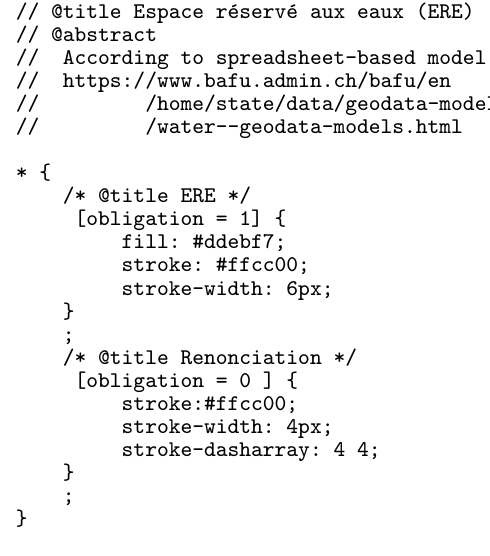
Figure 3. Styling and symbology instructions according to a spreadsheet-based model ( Area reserved for water MGM) Such styling and symbology instructions described in spread- sheet may then be formatted according to an encoding in con- formance with SymCore extensions and encodings (Bocher and Ertz, 2020).